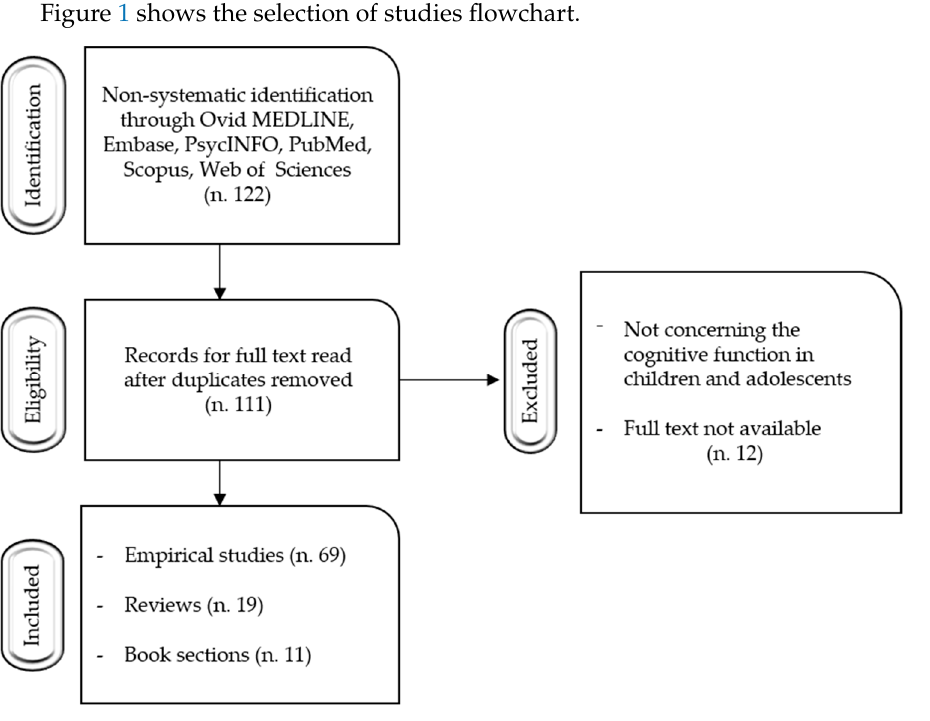
Figure 1. Selection of studies flowchart.